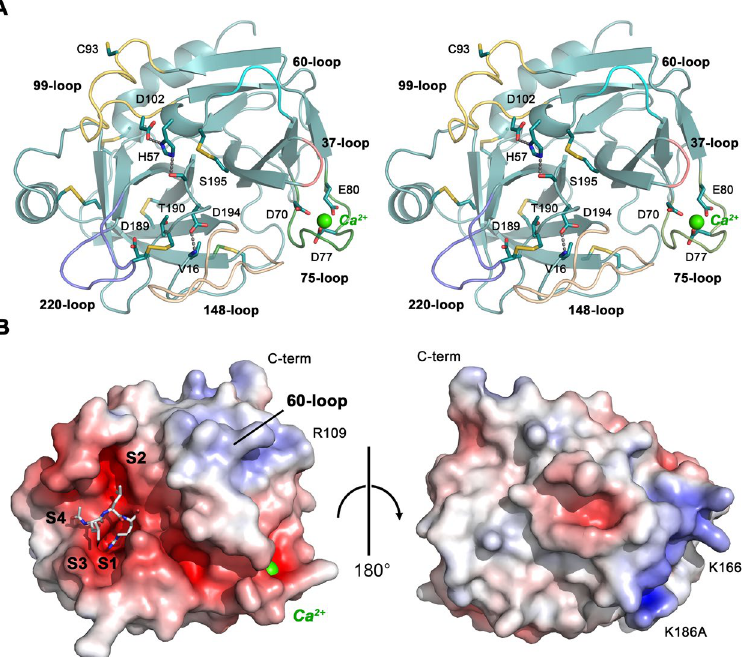
Figure 2. Overall structure of KLK8-Ca. ( A ) Ribbon stereo plot of KLK8-Ca shown in standard orientation. The side chains of the catalytic triad, the activating salt bridge Val16-Asp194, the major specificity-determining Asp189 and Thr190, as well as the six disulfide bridges and Cys93 are shown as sticks (carbon teal, nitrogen blue, oxygen red, and sulfur yellow). Also, the three major ligands of Ca 2 + (green sphere) are depicted, namely Asp70, Asp77 and Glu80. Functionally important loops are displayed in different colors with labels. ( B ) Surface model of KLK8 with inhibitor and Ca 2 + . The left panel shows KLK8 in standard orientation with a stick model of leupeptin, occupying the subsites S4 to S1. The electrostatic surface potential is depicted red for negative and blue for positive potential in the range − 10 e/k B T to + 10 e/k B T. The right panel shows the KLK8 backside, rotated by 180°. The 60-loop and the area around Arg109 correspond to the thrombin anion binding exosite I, while the positive patch at the back around Lys166 and Lys186A has no